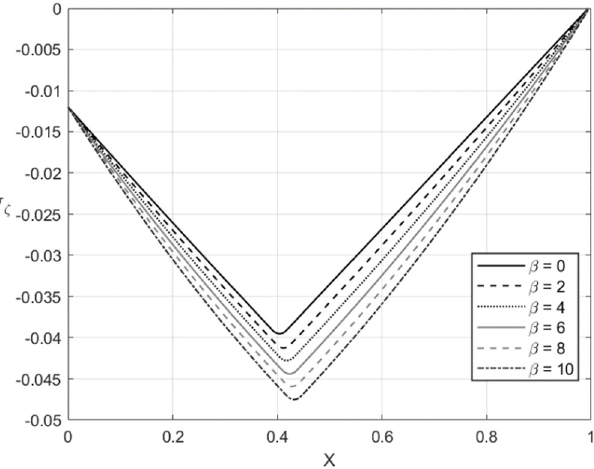
Figure 6. Through-thickness distribution of the stress σ η at H / r CD = 0.06, f = 0, and several values of β .